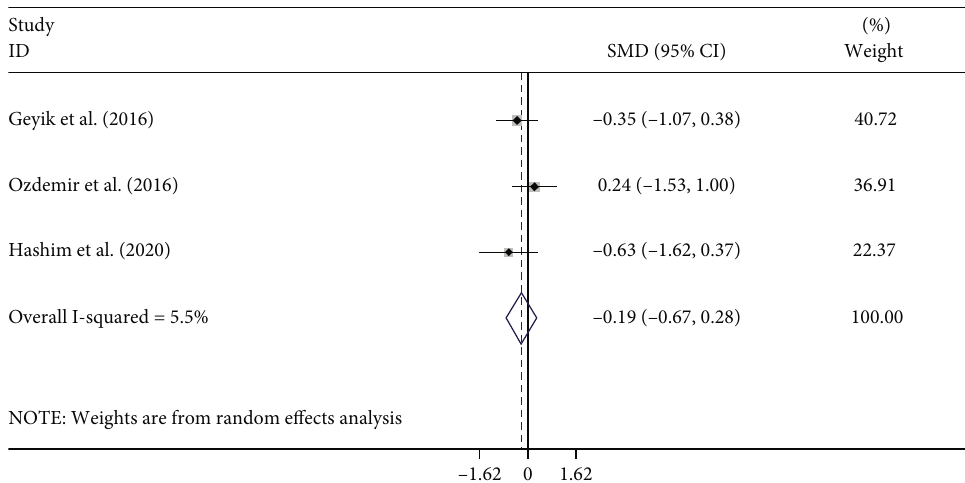
Figure 13: Meta-analysis of di ff erences in NLR levels between patients with AMSAN and AMSAN GBS.